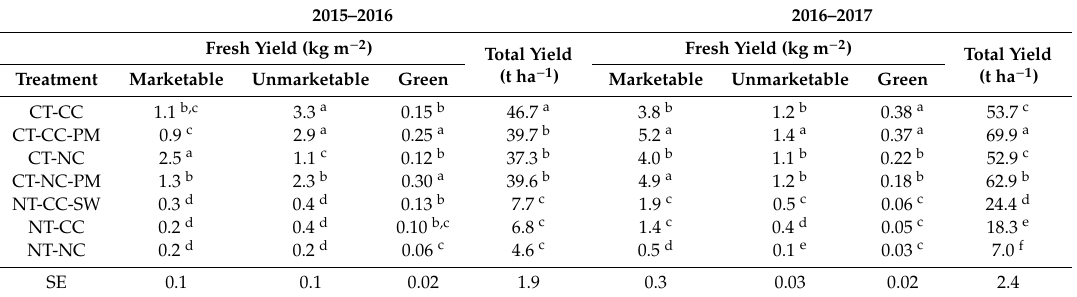
Table 5. Tomato yield obtained in each system as a ff ected by tillage and cover crop management.